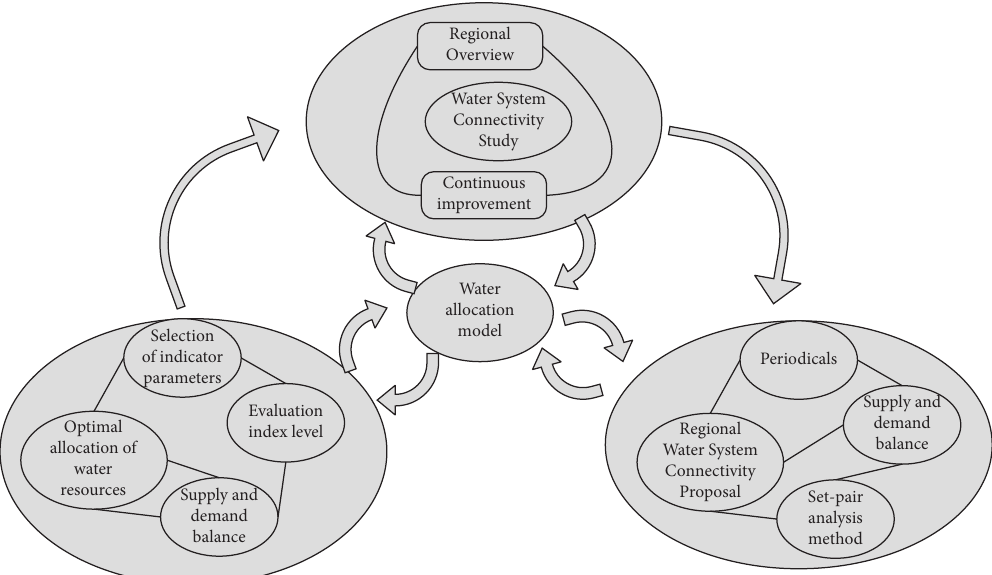
Figure 3: A technical route for optimal allocation of water resources in receiving areas based on adaptive decreasing inertia